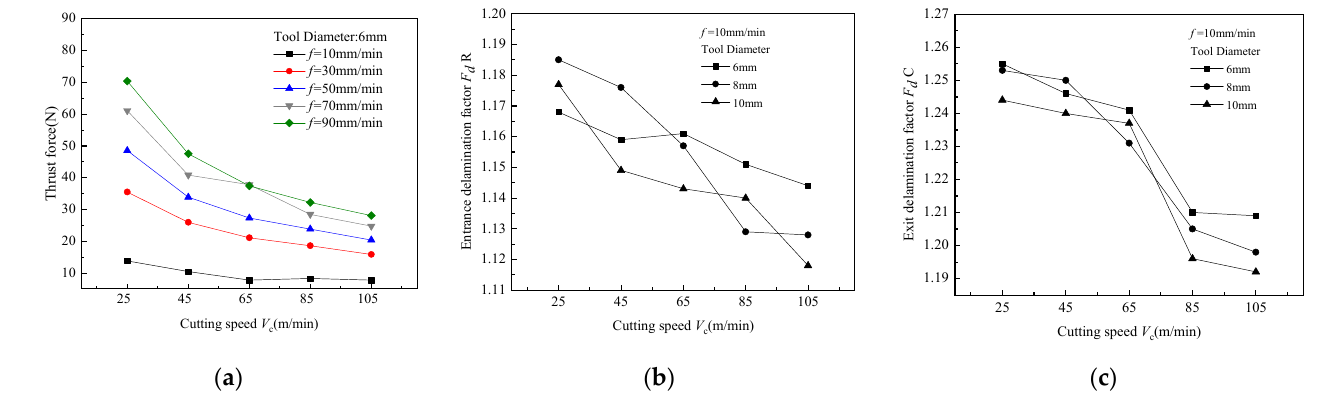
Figure 5. Entrance and exit delamination factors at different cutting speeds. ( a ) Effect of cutting speed on thrust force at different feed rates; ( b ) Entrance delamination factors at different cutting speeds; ( c ) Exit delamination factors at different cutting speeds.